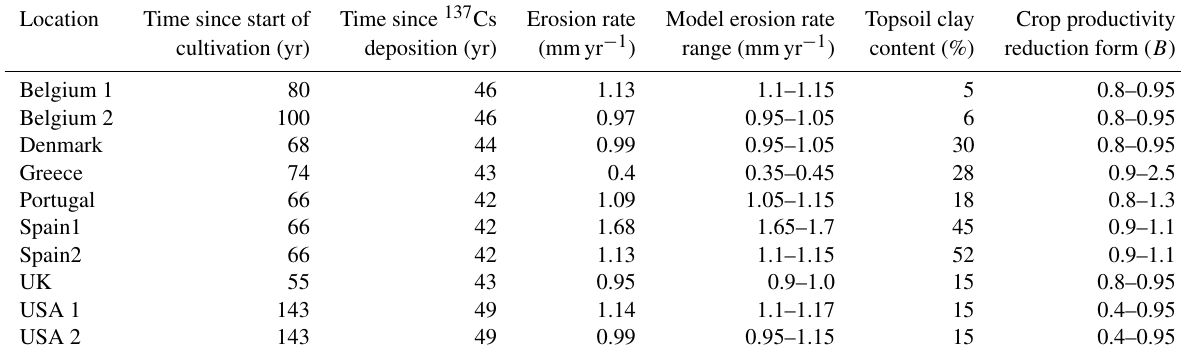
Table 1. Observed characteristics of the study sites used for the model evaluation. Site selection observed range of relative SOC loss and cumulative vertical fluxes are from Van Oost et al.